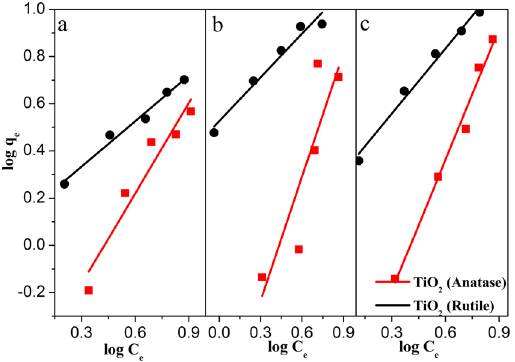
Figure 7. Freundlich adsorption isotherm model for ( a ) nitrobenzene, ( b ) 2-nitrotoluene, and ( c ) 2-fluoro- nitrobenzene anatase and rutile TiO 2 . The equilibrium concentration (q e ) of nitroarenes was calculated by using following equation: q e = (C 0 − C e )V/W, where C 0 and C e are initial and final concentrations of nitroarenes (mg/L), V is amount of solution (L) and W is weight of catalyst (g).